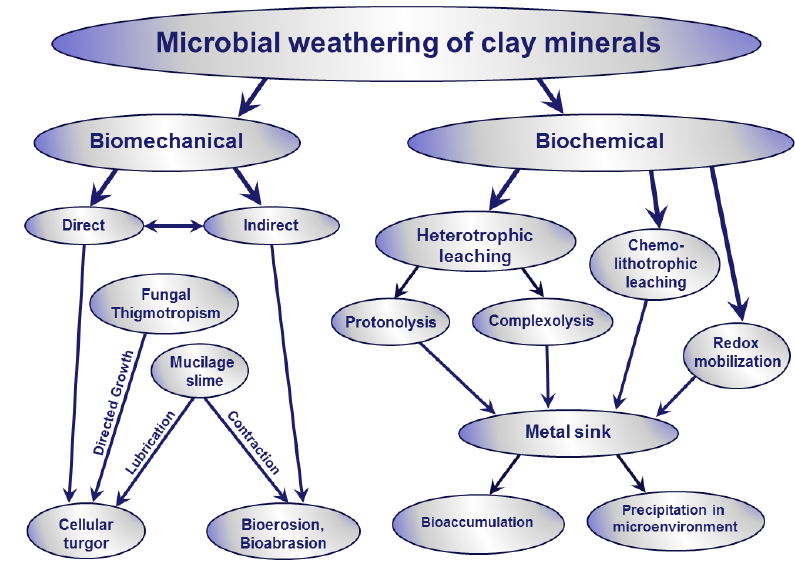
Figure 2. Main mechanisms of microbial weathering of clay minerals (adapted from [57]).